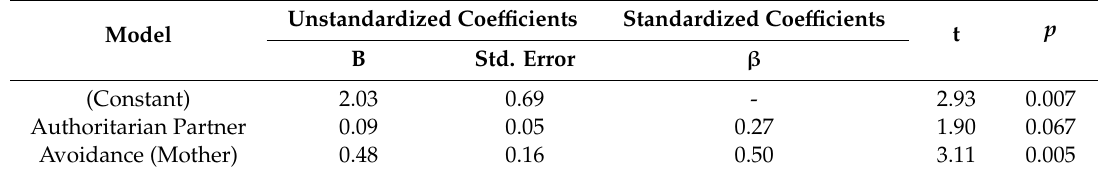
Table 6. Final model coe ffi cients for predicting avoidance of close relationships with the partner *. Model